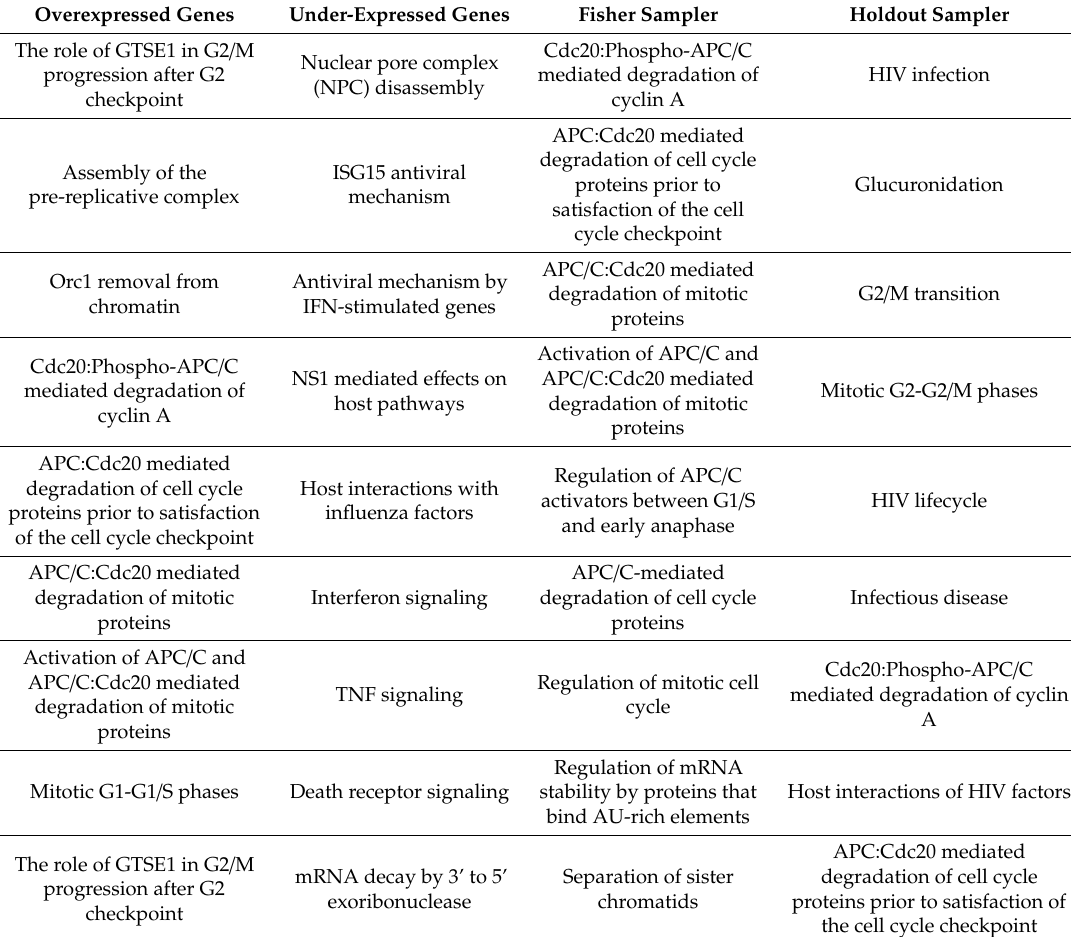
Table 4. GSE6477. Chromosome 13 deletion prediction. Pathway analysis via the Fisher’s ratio and holdout